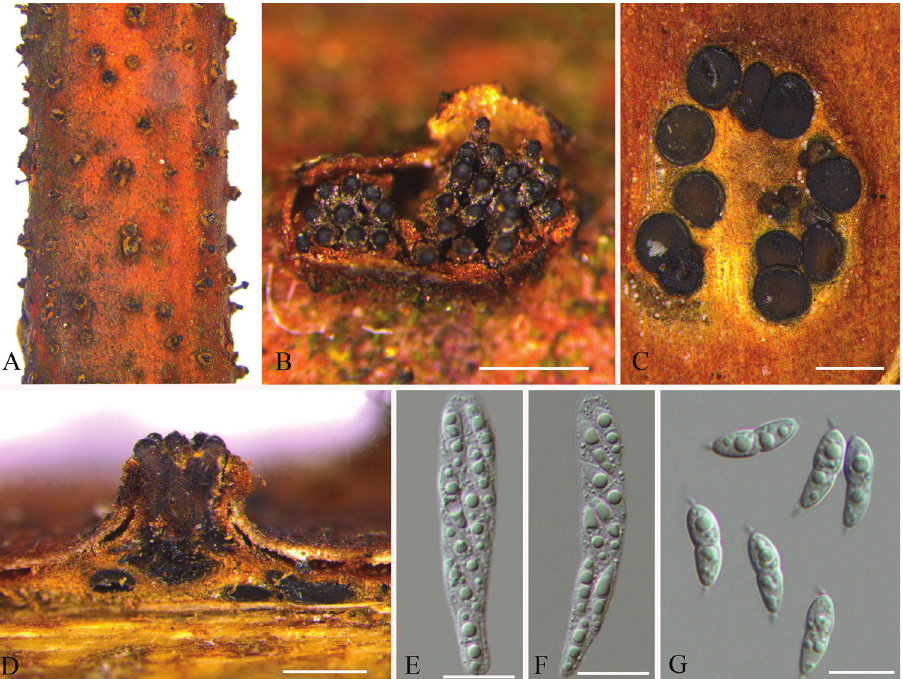
Figure 4. Sexual morphology of Synnemasporella aculeans on Rhus chinensis (BJFC-S1745) A, B habit of ascomata on twigs C transverse section of ascomata D longitudinal section through ascomata E, F asci G ascospores. Scale bars: 500 µm ( B–D ); 10 µm ( E–G